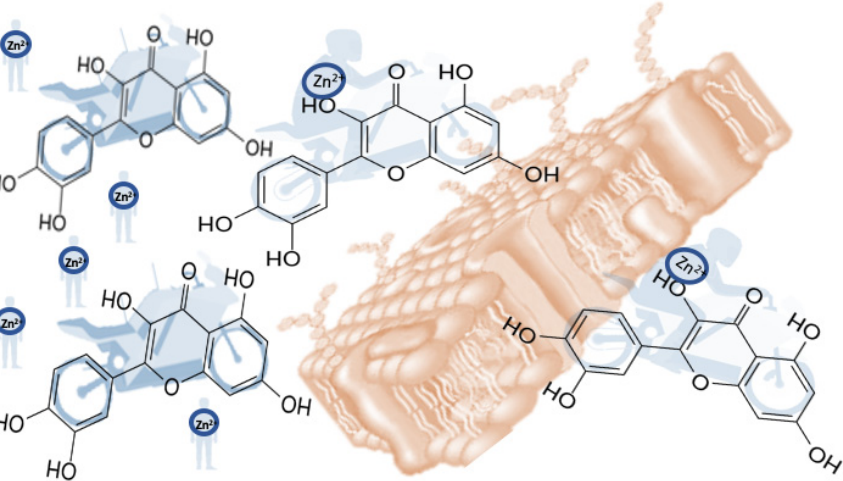
Figure 12. Biker/motorcycle analogy model of flavonoids acting as zinc ionophores. The metal binding event permits the ionophore to traffic metal cations across the hydrophobic environment of cell membranes. In the bound state, the zinc cations (biker) and flavonoids (motorbikes) are sufficiently hydrophobic to permit passage across lipid membranes, where the zinc ions would not be soluble.